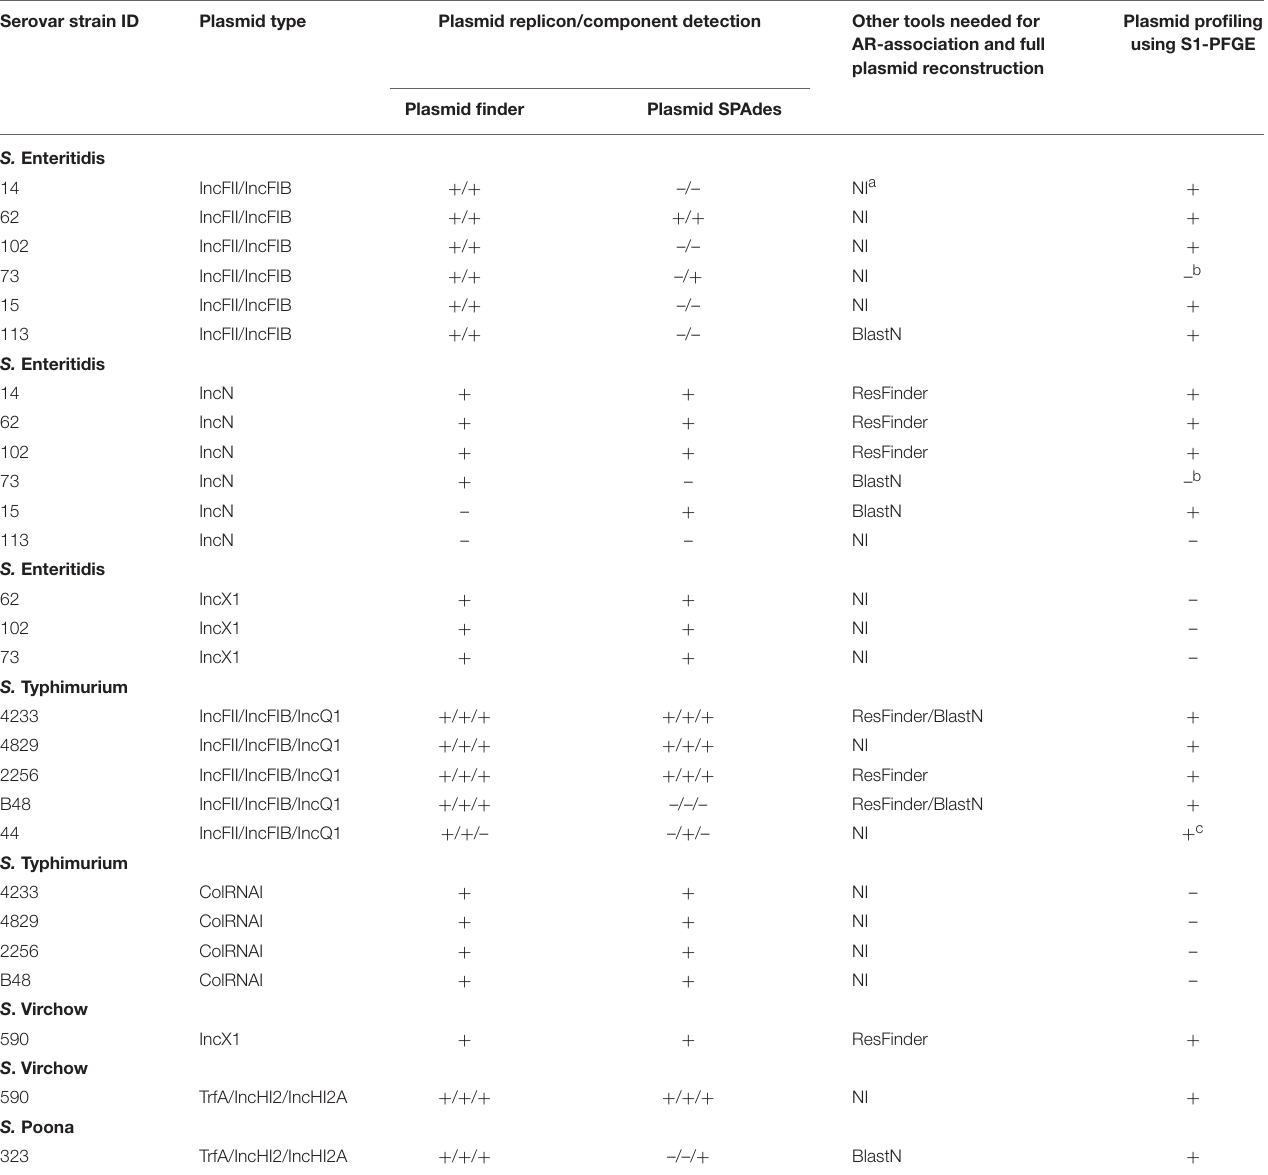
TABLE 2 | Performance of bioinformatic tools in respect to plasmid reconstruction and detection of antimicriobial resistance gene location in the whole genome sequences of the Salmonella strains under study. Serovar strain